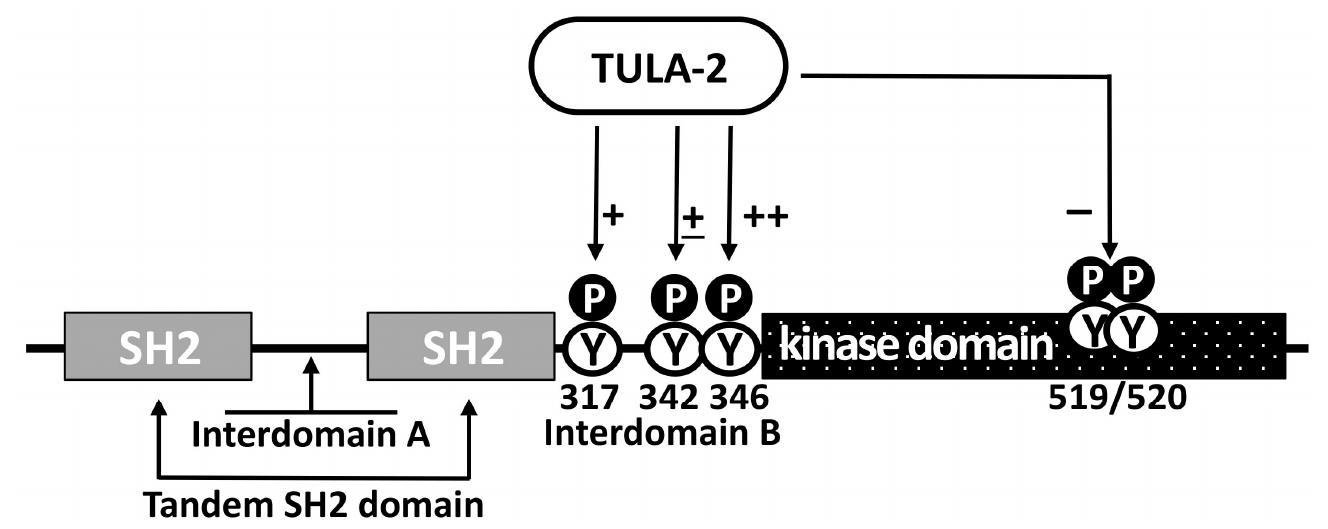
Figure 3. Effect of TULA-2 on Syk regulatory phosphotyrosines. Major domains, interdomain regions and regulatory phosphotyrosines (pY) of Syk are depicted (residue numbering is for mouse Syk). pY342 and pY346 exert positive regulatory effects on Syk, while pY317 is a negative regulatory site. The pY519/pY520 site is located in the activation loop of Syk and represents a marker of Syk activation. The differential ability of TULA-2 to dephosphorylate the sites depicted here is indicated and varies from very strong (++) to strong (+) to moderate (±) to the lack thereof ( − ). See the text for detail.